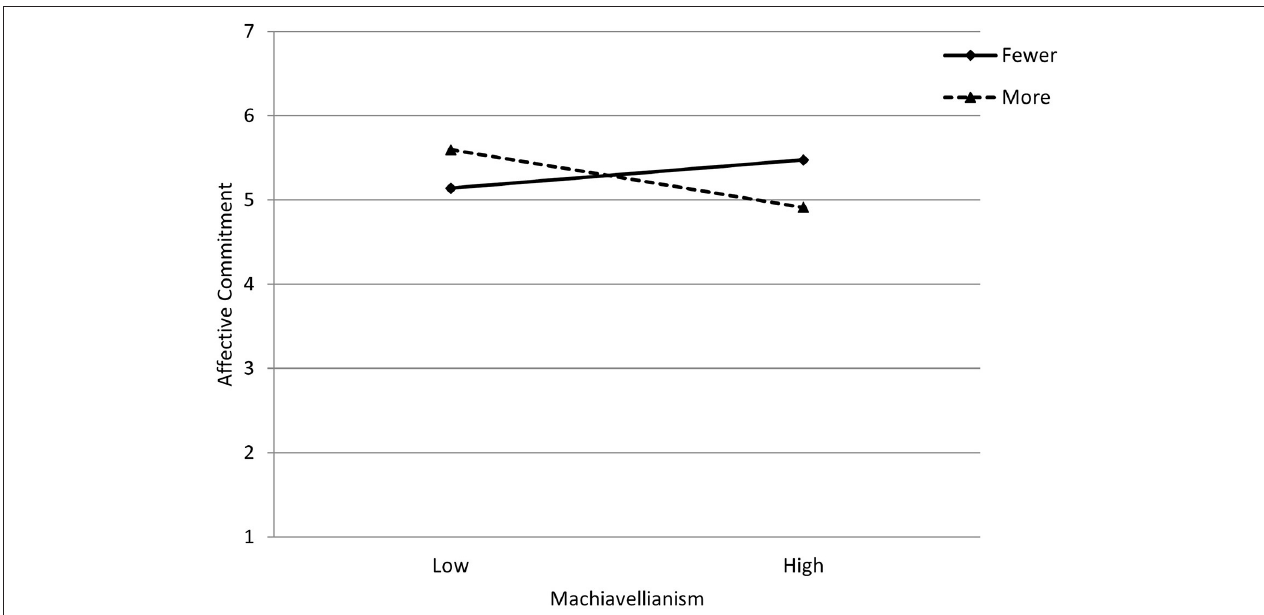
FIGURE 1 | Interaction between Machiavellianism and years of part-time and casual employment in their impact on affective commitment. Lines represent years of part-time and casual work at − 1SD = Fewer and + 1SD = More from the mean.